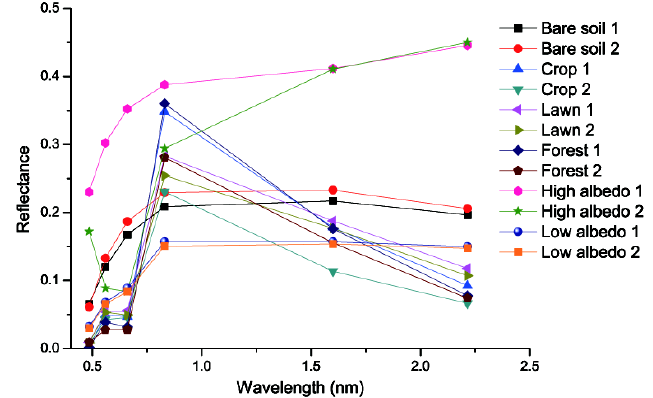
Figure 3. Spectral reflectance of endmembers used for the MESMA.